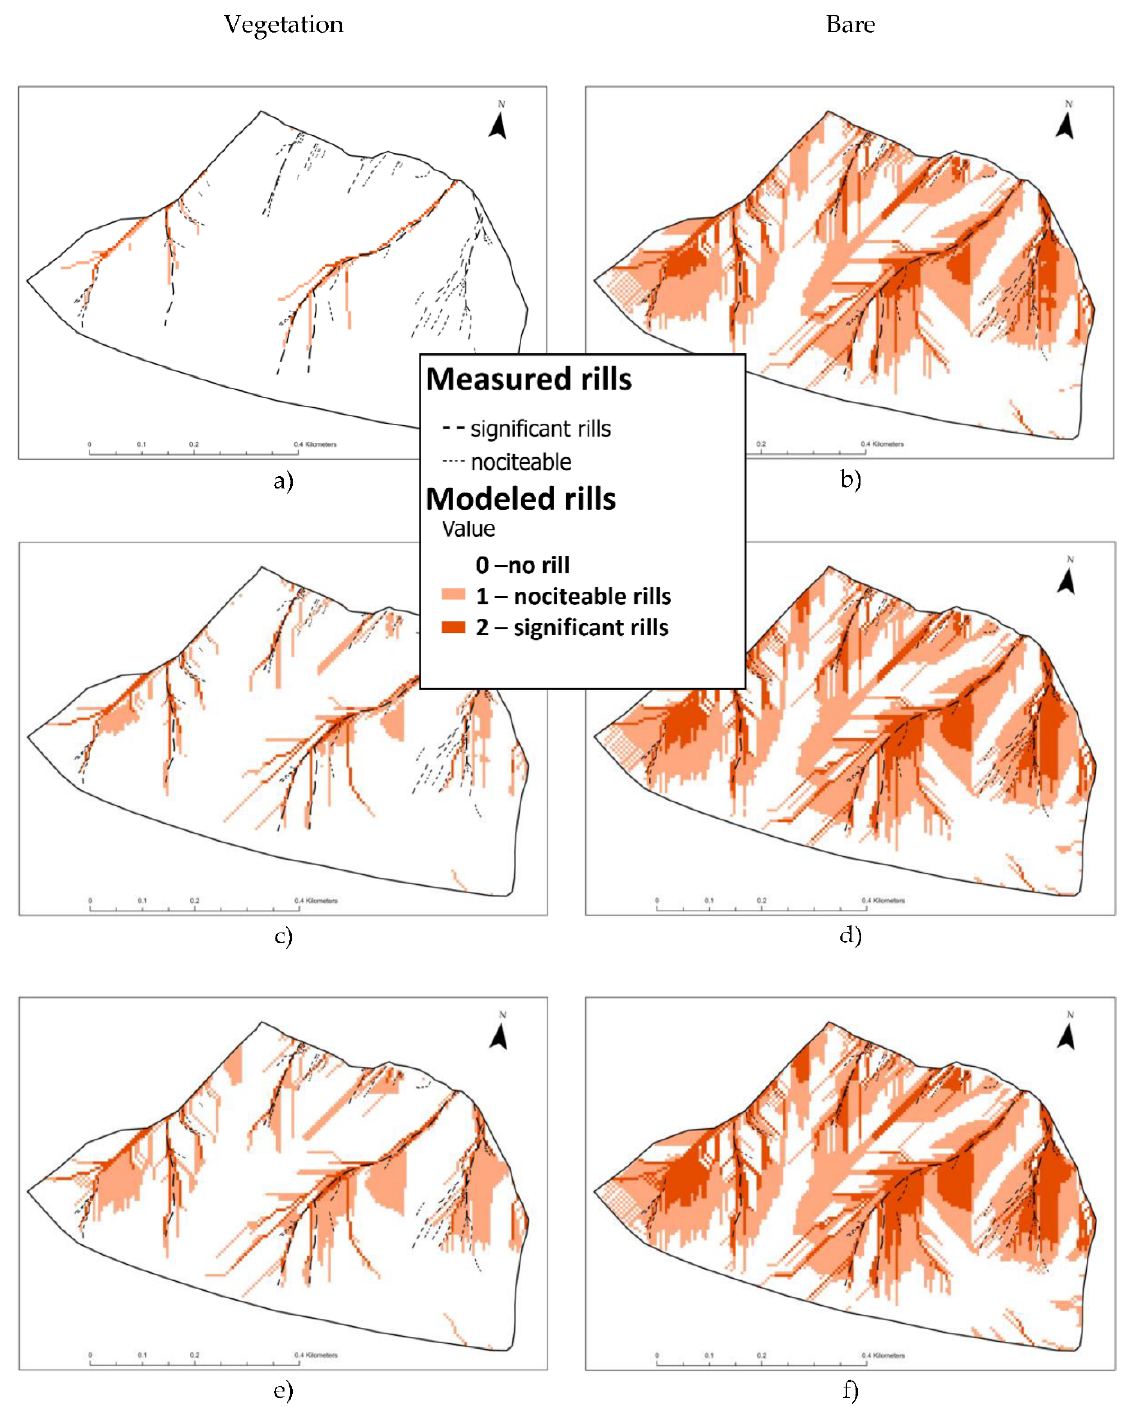
Figure 10. The figure shows the rills based on measurements (significant rill—a bold dashed line, noticeable rill—a thin dashed line) and calculated rills (significant rill 2—red, noticeable rill 1—orange) of the single runoff event. Maps ( a , c , e ) show models with vegetation. Maps ( b , d , f ) show model with bare soil. Maps ( c , d ) show MEAN values of the model parameters, maps ( a , b ) show the MEAN – STD values, and maps ( e , f ) show the MEAN + STD model parameters.